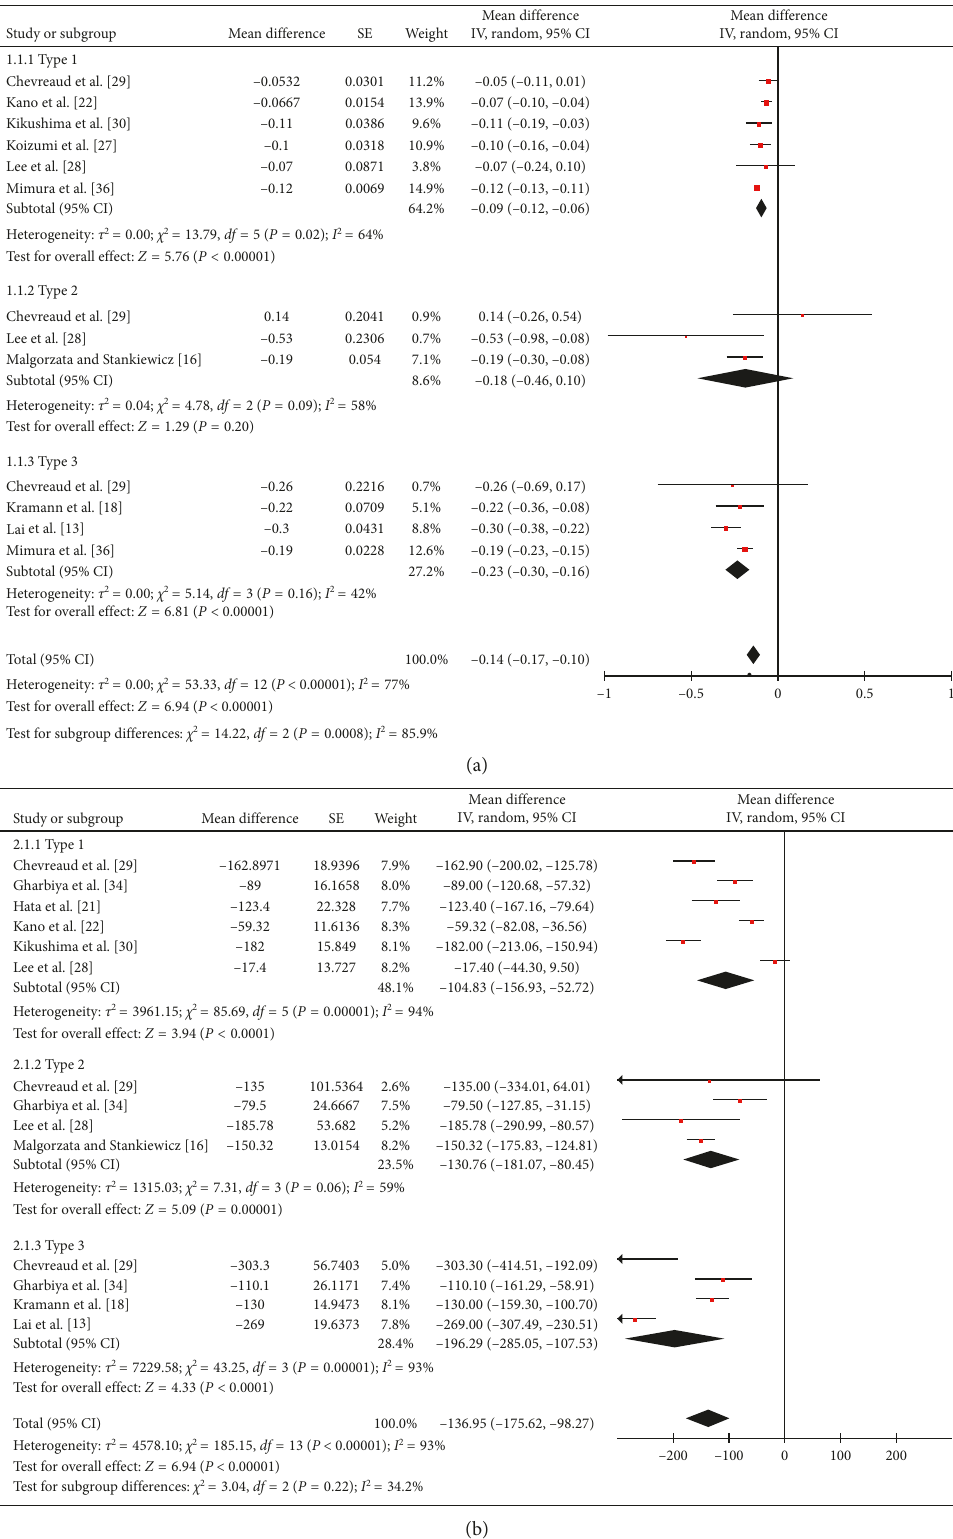
Figure 3: The short-term (3 months) efficacy comparison of antivascular endothelial growth factor (anti-VEGF) therapy for three subtypes of neovascular age-related macular degeneration (nAMD). (a) Vision improvement of the three types of nAMD, measured by logarithm of the minimum angle of resolution (logMAR),